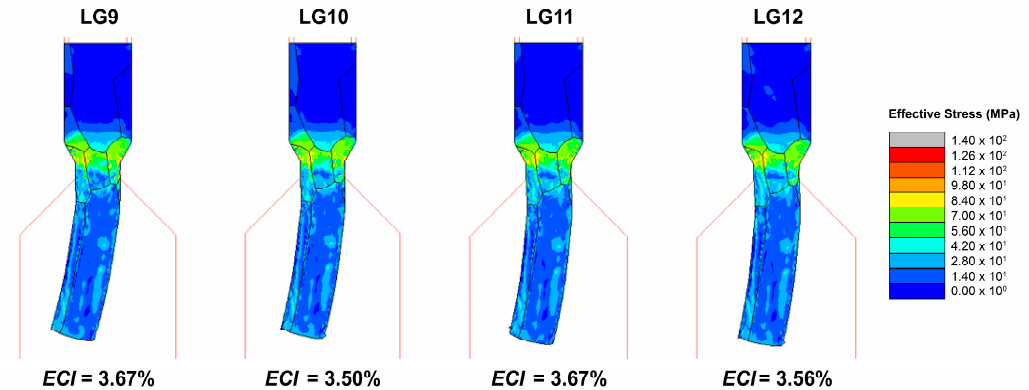
Figure 19. The micro-extrusion results of the considered conditions (LG9–LG12).